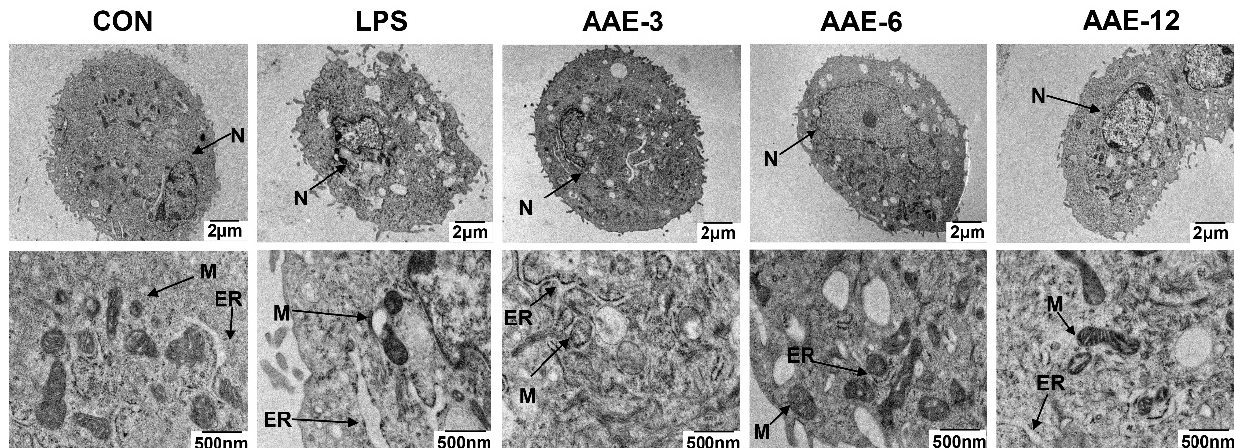
Figure 4. Effect of AAE on ultrastructural changes. The bMECs were treated with AAE (3, 6, 12 µ g/mL) for 3 h, followed by 10 µ g/mL LPS stimulation for 12 h. Transmission electron microscope (TEM) was used to test the protective effect of AAE on the ultrastructural changes of bMECs damaged by LPS. N, M and ER represent nucleus, mitochondria and endoplasmic reticulum, respectively. CON: cells were cultured in medium (serum-free) for 15 h; LPS: cells were cultured in medium (serum-free) for 3 h and then incubated with 10 µ g/mL LPS for 12 h; AAE-3, AAE-6 and AAE-12: cells were treated with 3, 6 and 12 µ g/mL AAE for 3 h before 10 µ g/mL LPS incubation for 12 h.